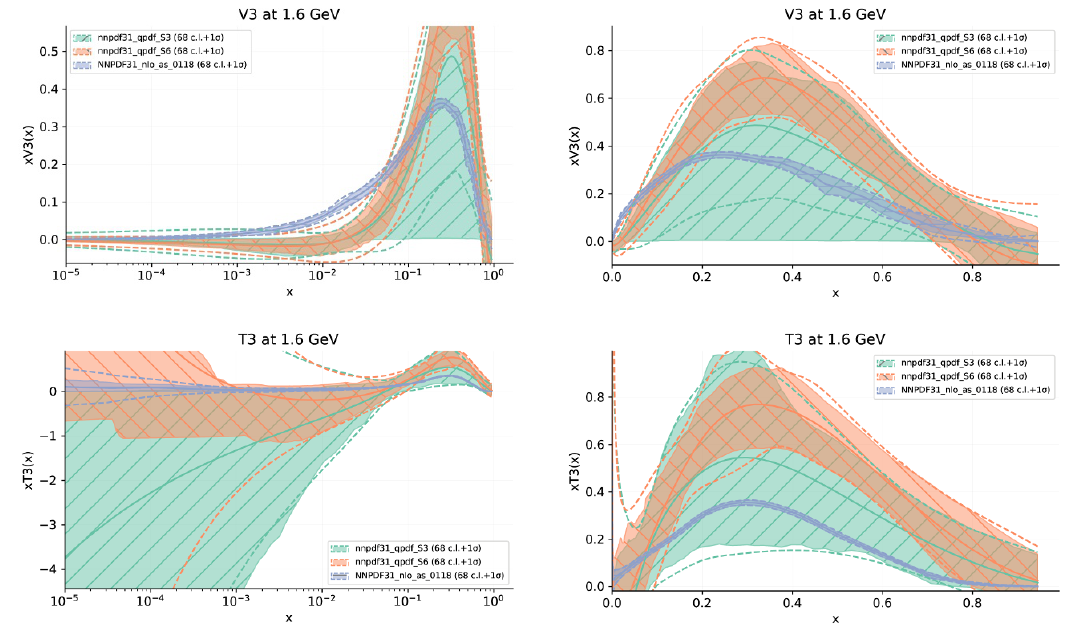
Figure 7 . S3 vs. S6: S3 results are extremely conservative, while those for S6 do not show a qualitative di(cid:11)erence with respect to S4 and S5.